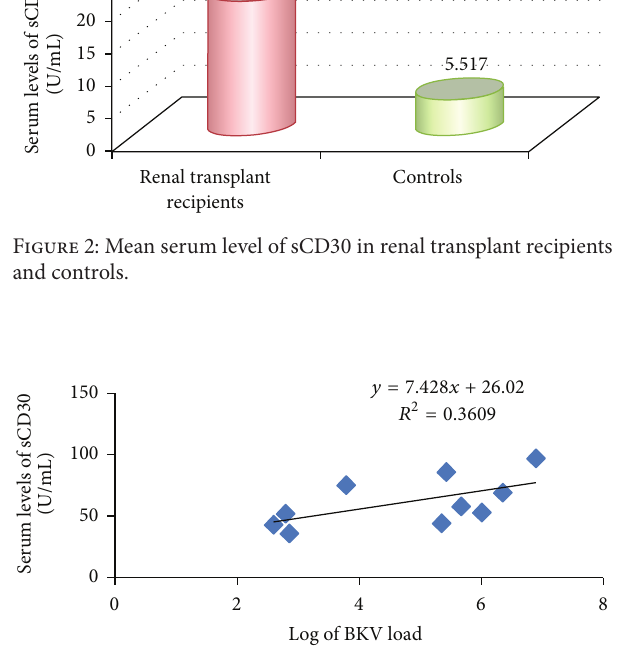
Figure 3: The association between sCD30 and BKV